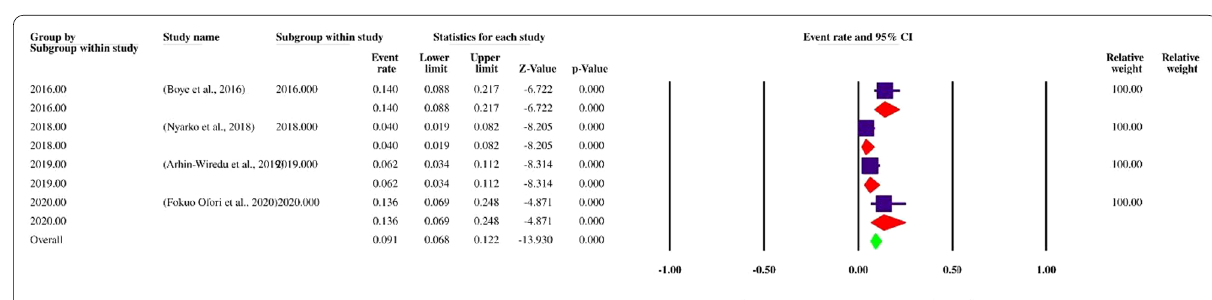
Fig. 6 Forest plot of year-based prevalence in Ghana (2016–2020)